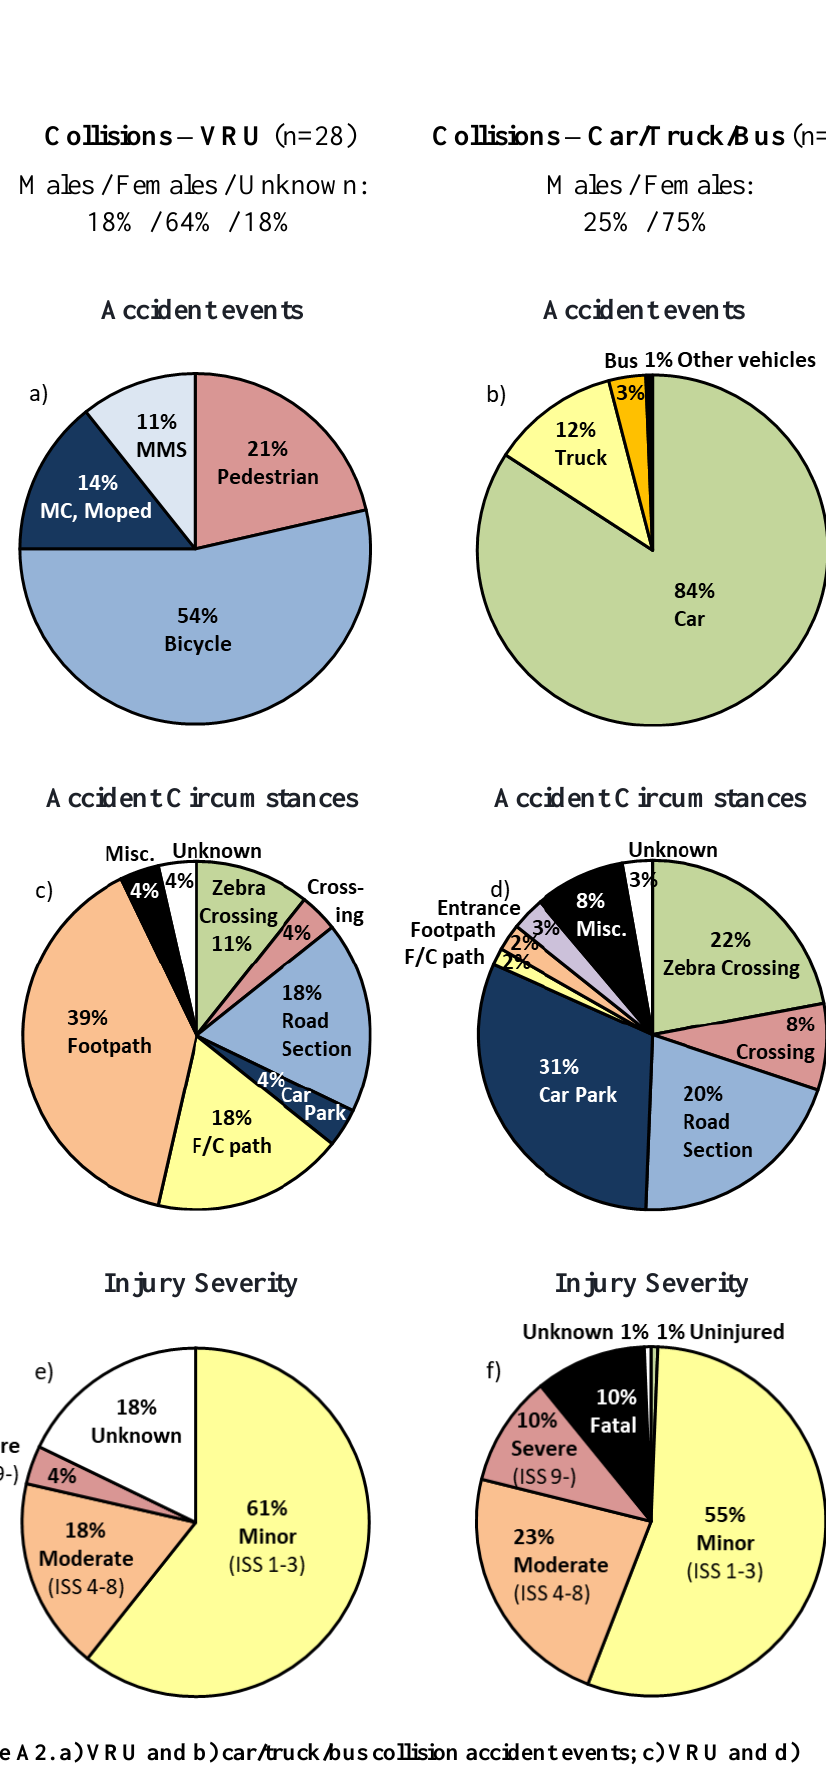
Figure A2. a) VRU and b) car/truck/bus collision accident events; c) VRU and